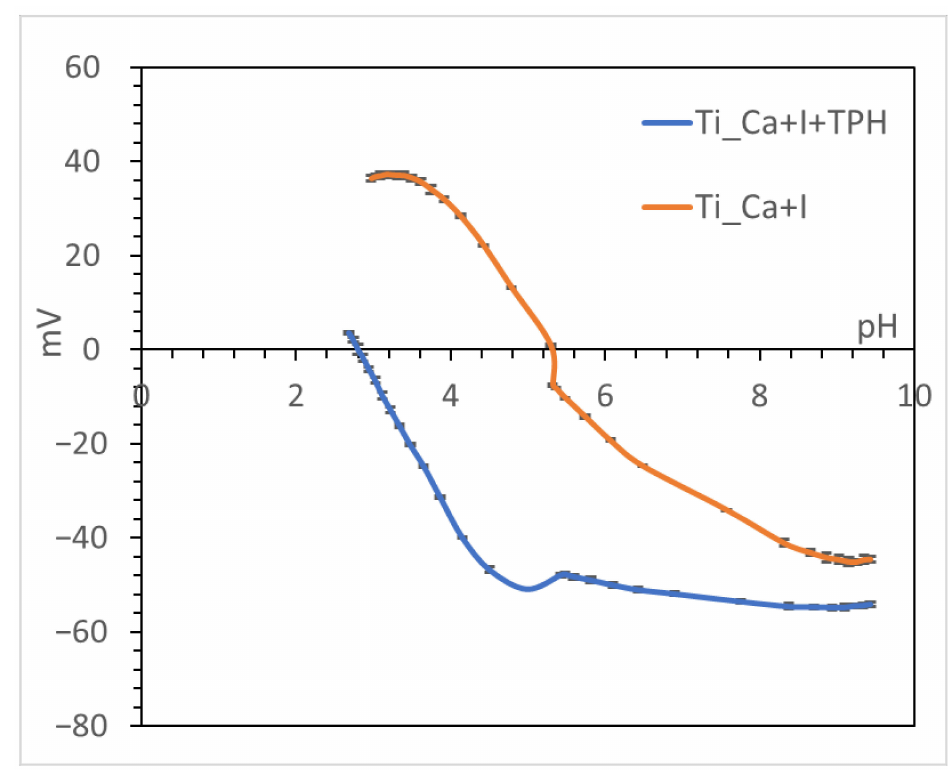
Figure 3. Zeta potential titration curve for Ti_Ca+I and